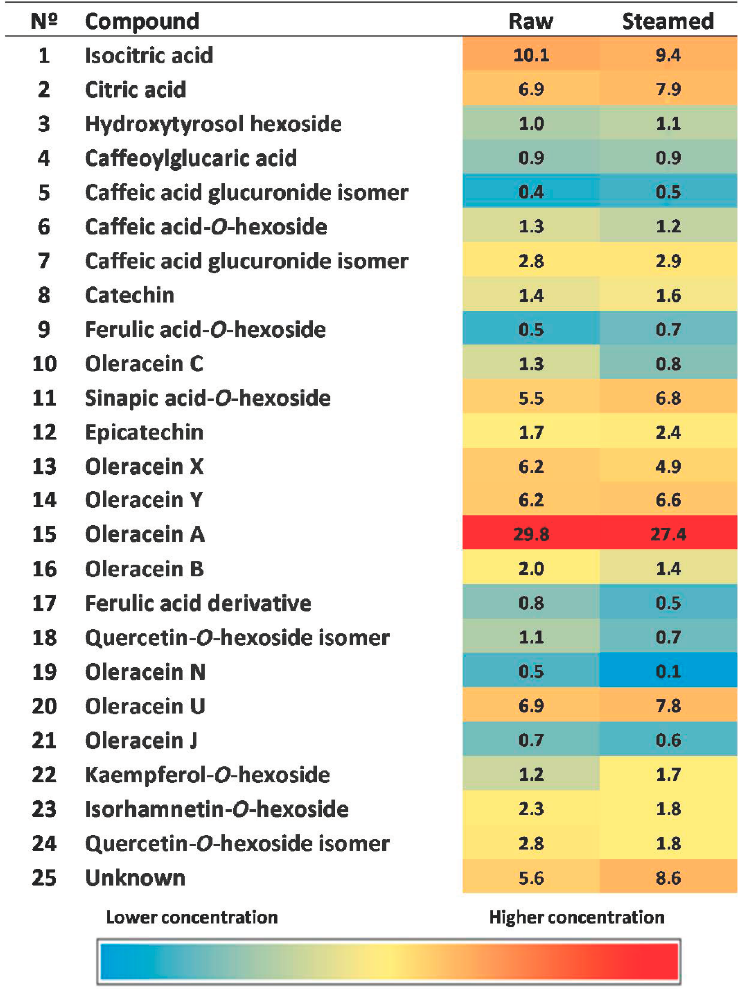
Figure 6. Relative peak areas and heat map of the raw and steamed extracts of Portulaca oleracea aerial parts.